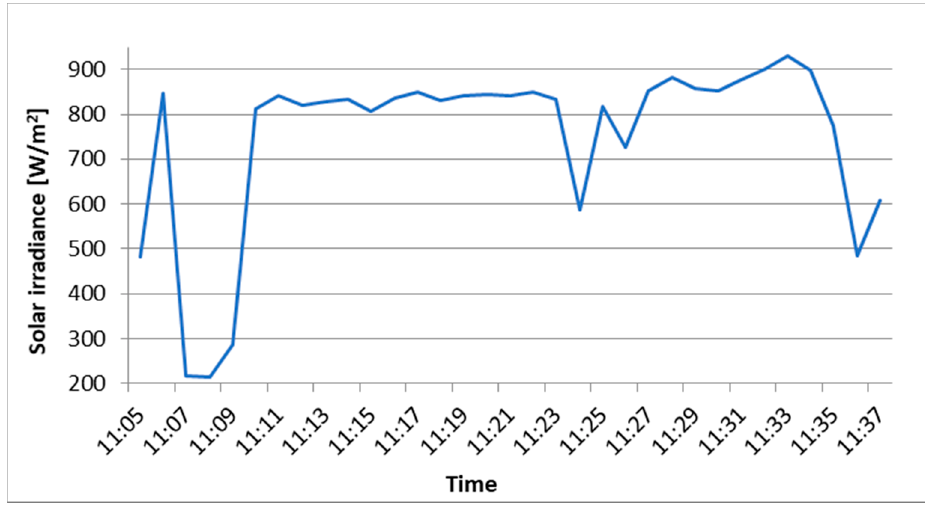
Figure 5. Solar irradiation during the comparative 30-min test.